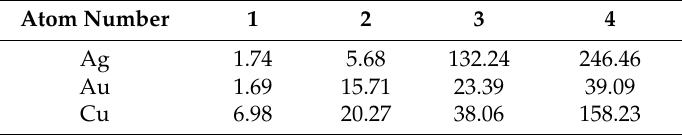
Table 4. Comparison of EF (Enhancement Factors) corresponding to three kinds of metal atom in different quantities (EF= (I SERS /N SERS )/(I Raman /N Raman )). (I SERS and N SERS represent signal strength and number of molecules in SERS, I Raman and N Raman represent signal strength and number of molecules in normal